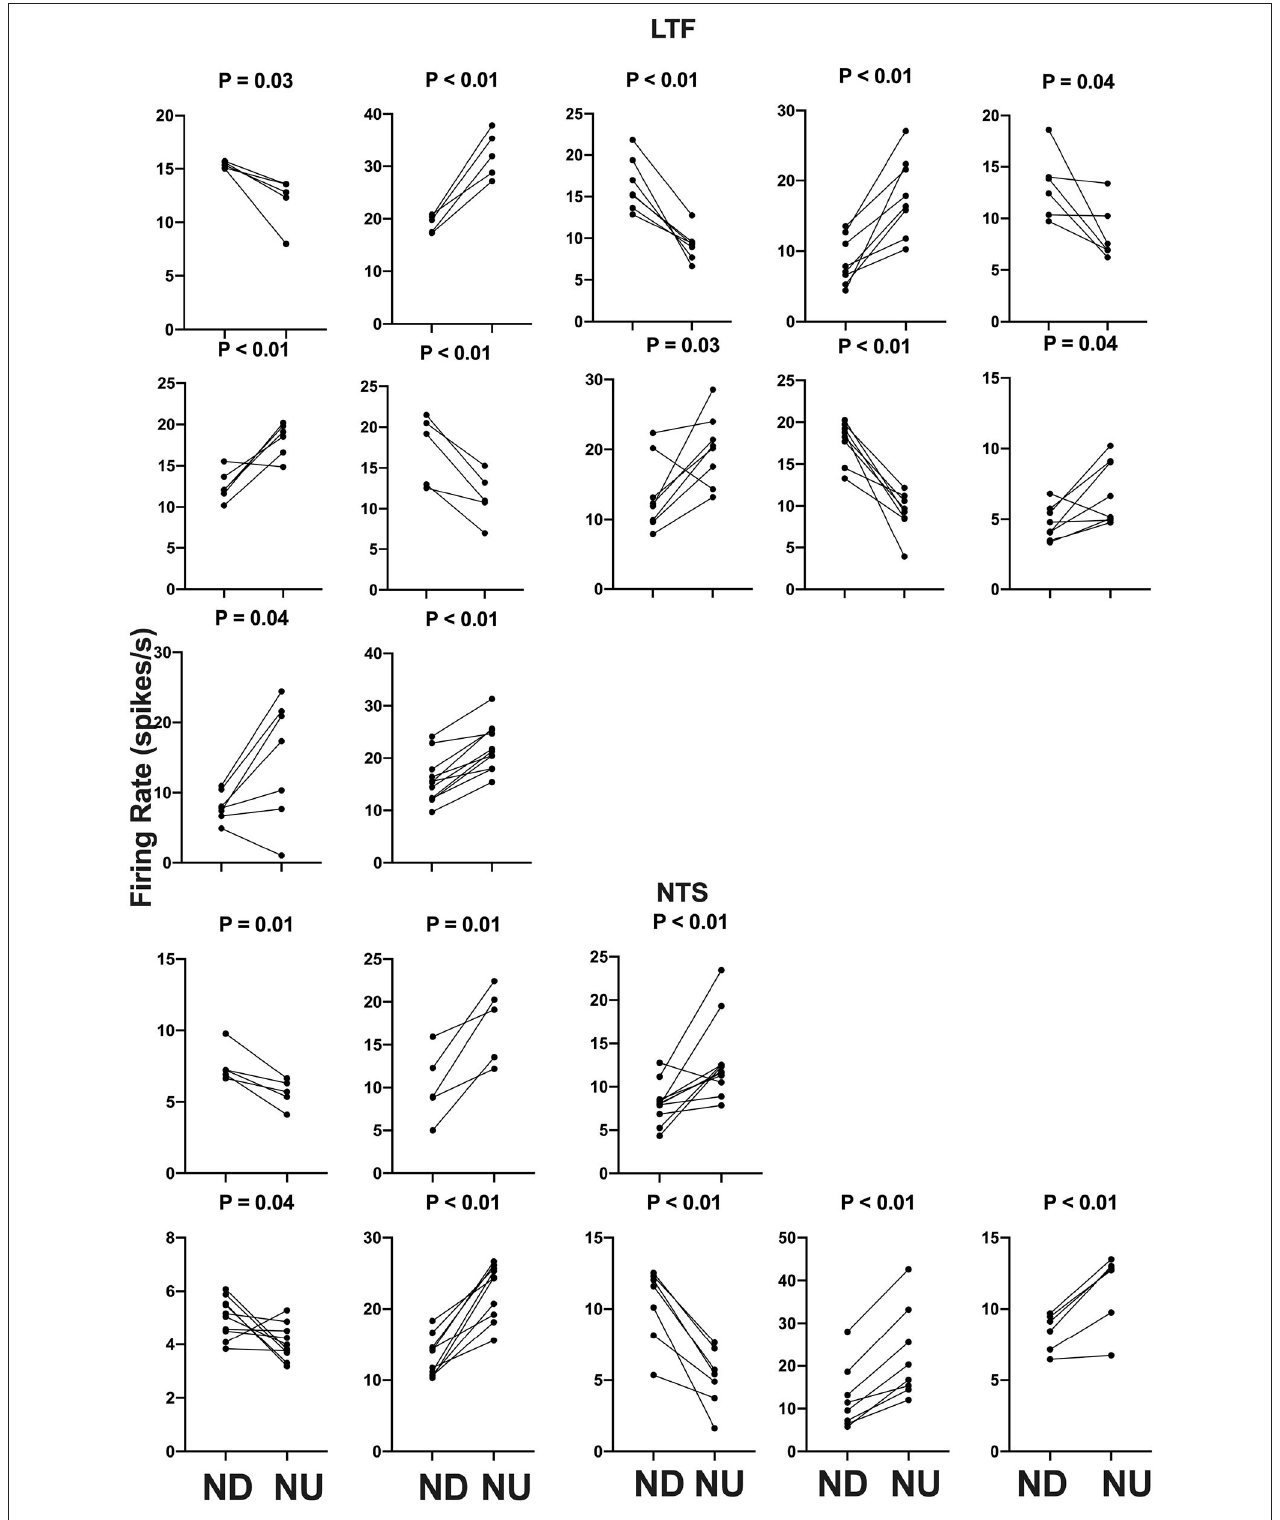
FIGURE 7 | Firing rate during each trial for the 12 LTF and 8 NTS units with CRA whose activity was significantly modulated by 40 ◦ head-up tilt. Each panel depicts the firing rate for a single unit when the animal was positioned 20 ◦ nose-down (ND) and then subsequently positioned 20 ◦ nose-up (NU). P -values indicating the significance of the difference in firing rate in the ND and NU positions (paired t -test) are provided above each panel. The greatest significance level indicated is P < 0.01.